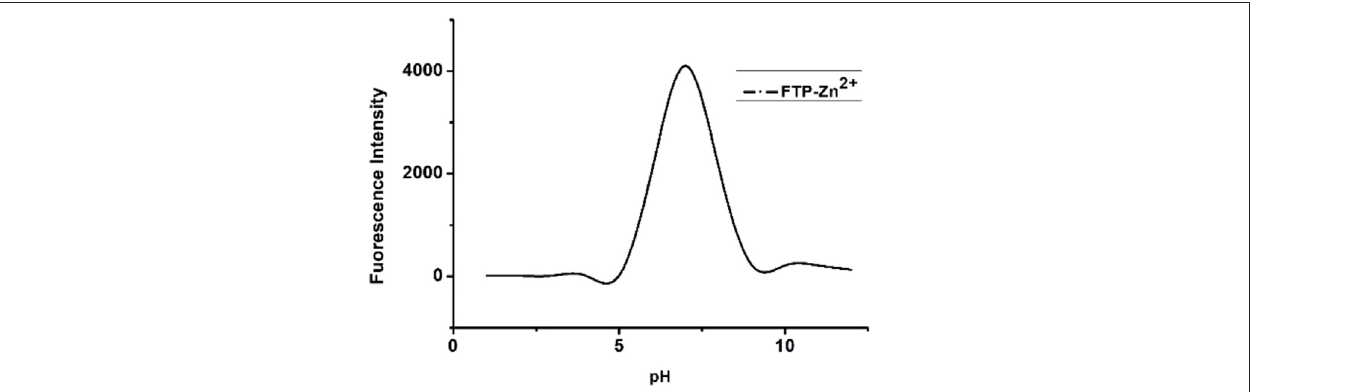
Frontiers in Chemistry |